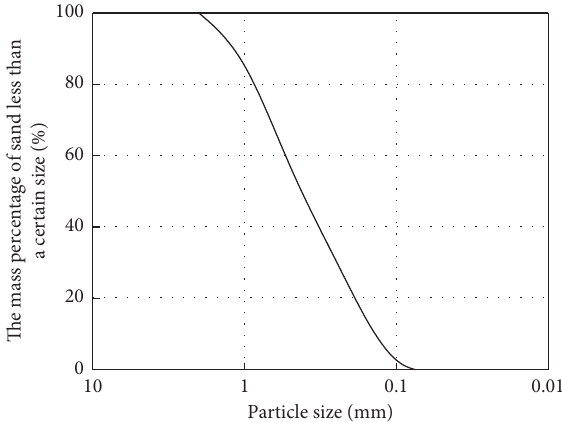
Figure 1: Grain distribution curve of samples.